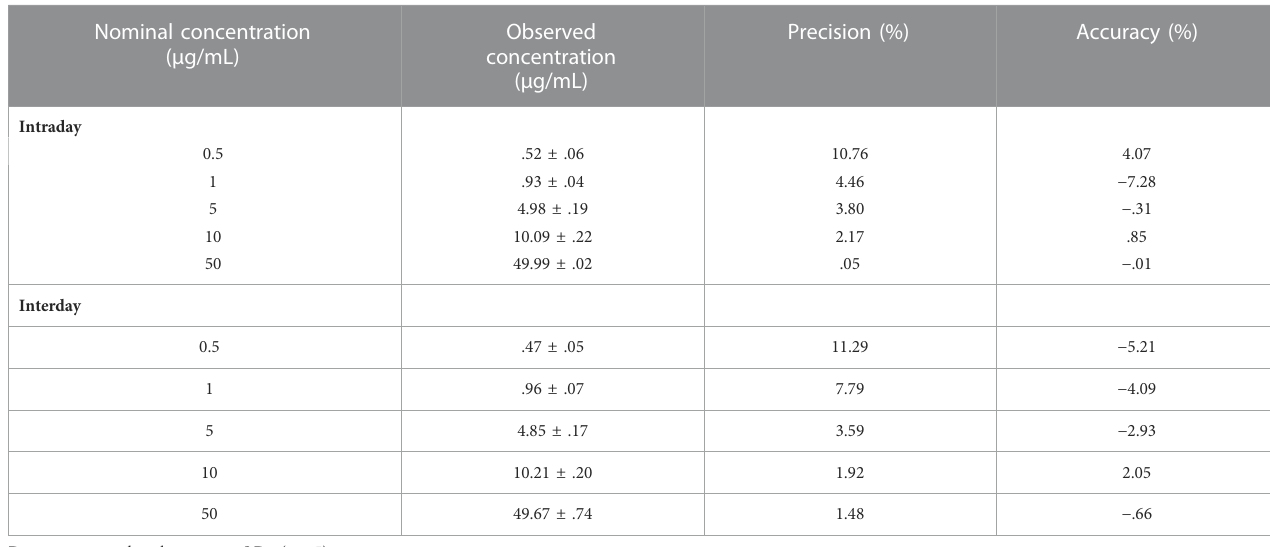
TABLE 1 Intraday and interday precision and accuracy of canrenone in urine samples. Nominal concentration ( μ